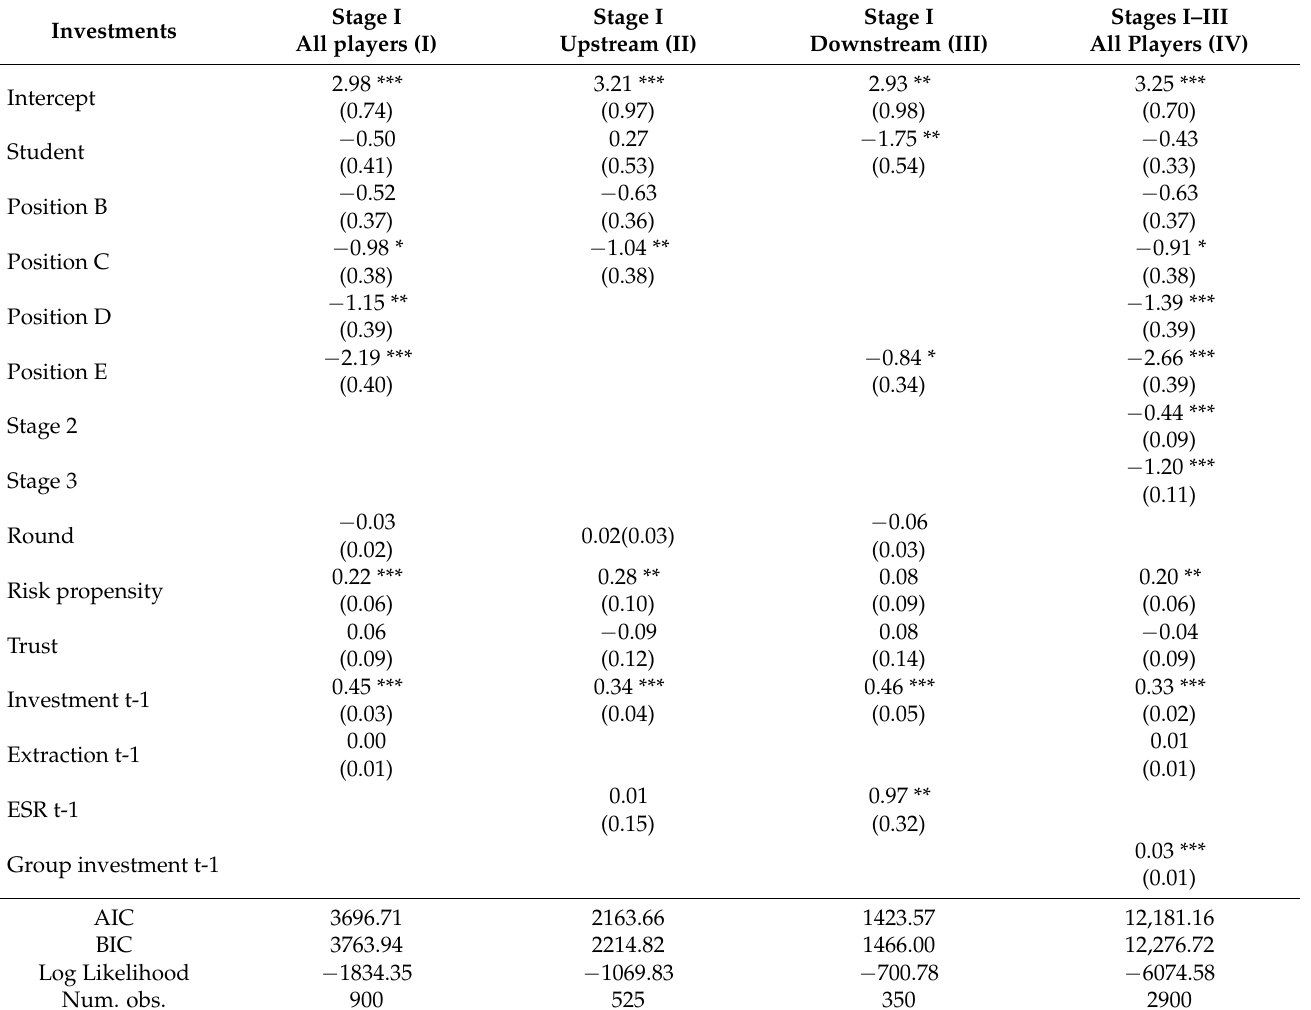
Table 2. Regression results of Stages